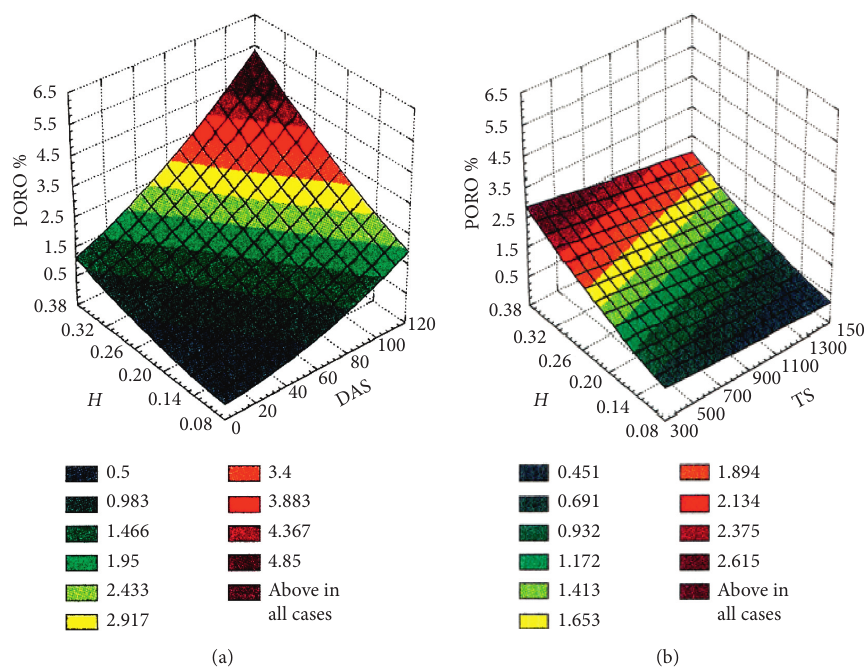
Figure 7: (a) Porosity-hydrogen-DAS relationship [27]. (b) Porosity-hydrogen-solidification time relationship